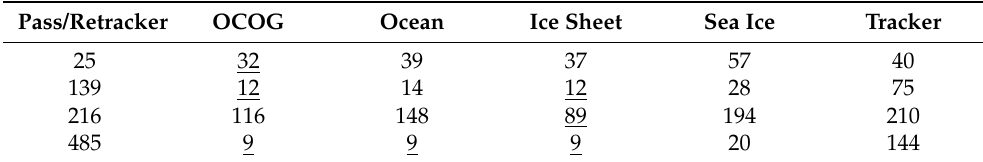
Table 3. RMSE values (cm) of water level variations derived from L2 products compared to the tide gauge data.